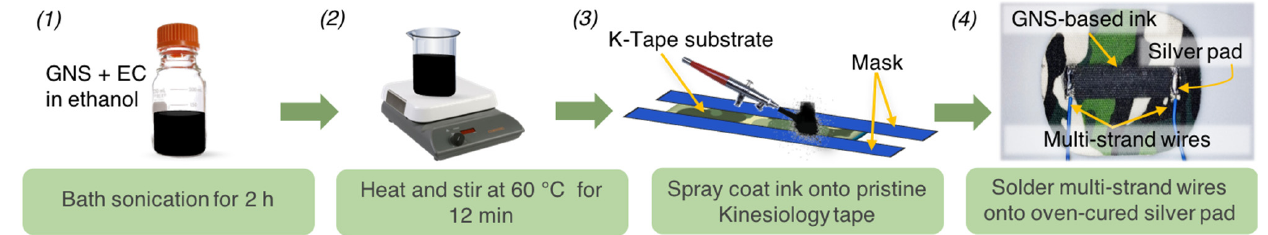
Figure 1. Motion Tape was fabricated by ( 1 ) first preparing the GNS/EC-EtOH solution and ( 2 ) heating while stirring it. ( 3 ) Spray-coating was employed to deposit GNS/EC-EtOH ink onto masked self-adhesive K-Tape substrates ( 4 ) to form each Motion Tape specimen.